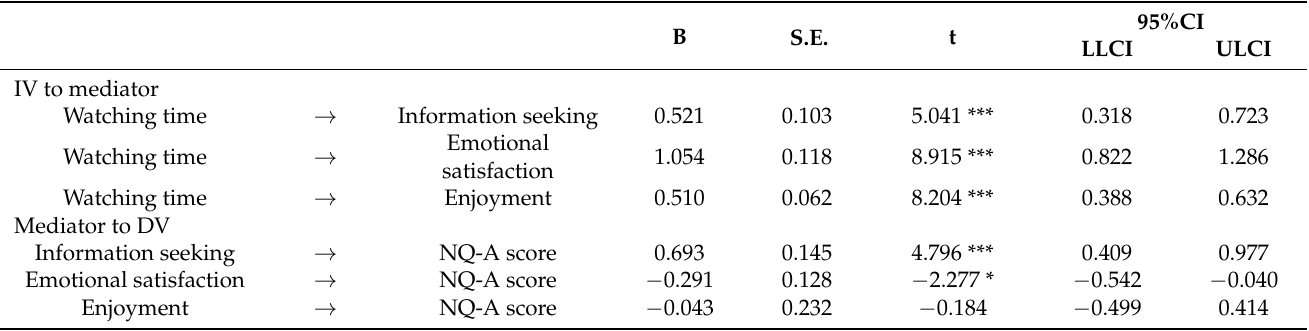
Gender, age and BMI are adjusted for the model. Food content watching timeis converted using logs for normal